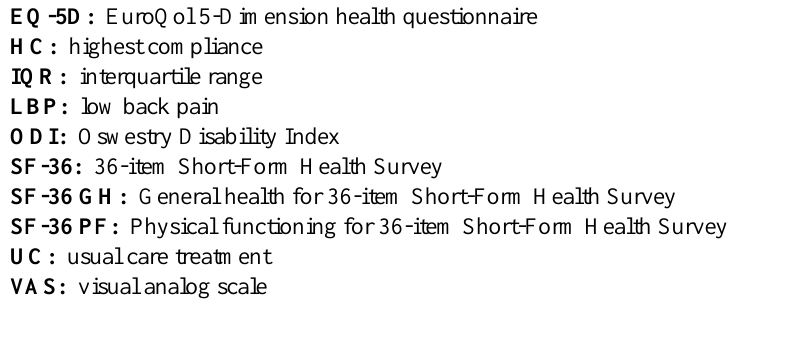
EQ-5D: EuroQol 5-Dimension health